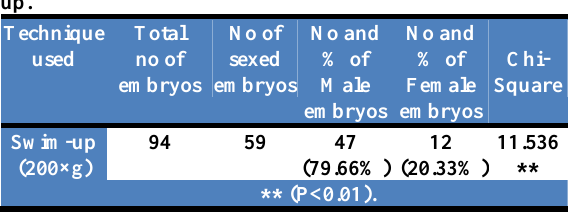
Table, 4: Number and percentage of male and female local goat embryos after detection of their sex by PCR and obtained after IVF using caudal sperms selected by swim-